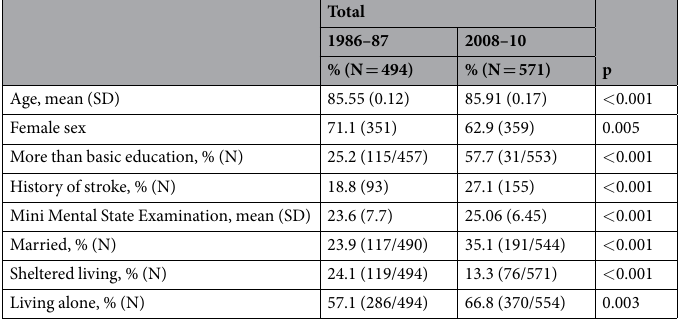
Table 1. Characteristics of 85-year-olds examined in 1986–87 and 2008–10. SD = standard deviation.